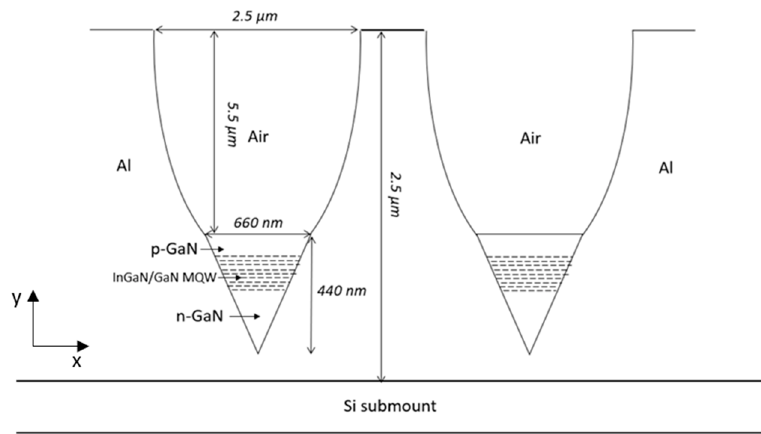
Figure 1. Presentation of a cross section of an array of two adjacent LENS devices. The design includes a Reflective Coned Nano-Green LED with a Compound Parabolic Concentrator (CPC). The figure is voluntarily not to scale in order to present the new concept.